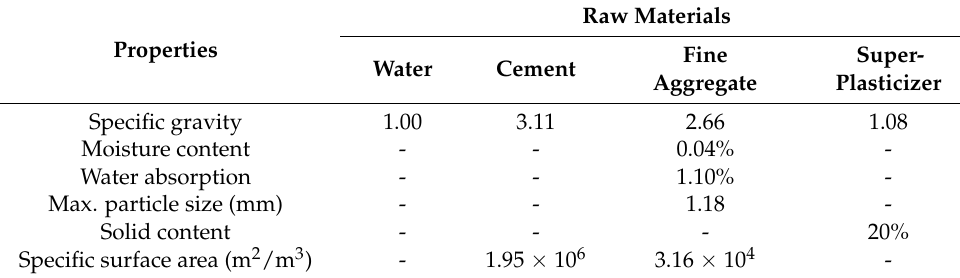
Table 1. Properties of raw